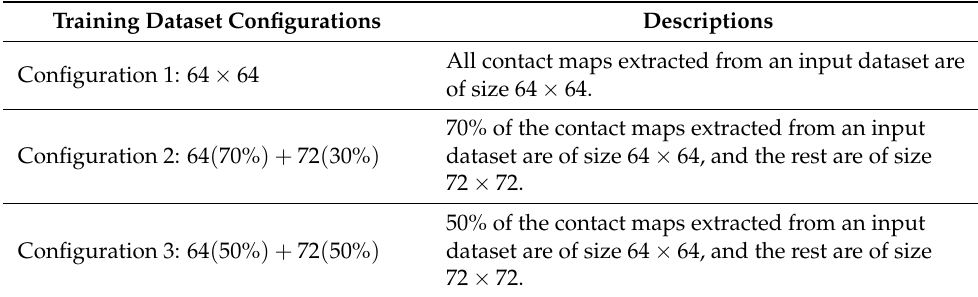
Table 1. Descriptions of different training dataset